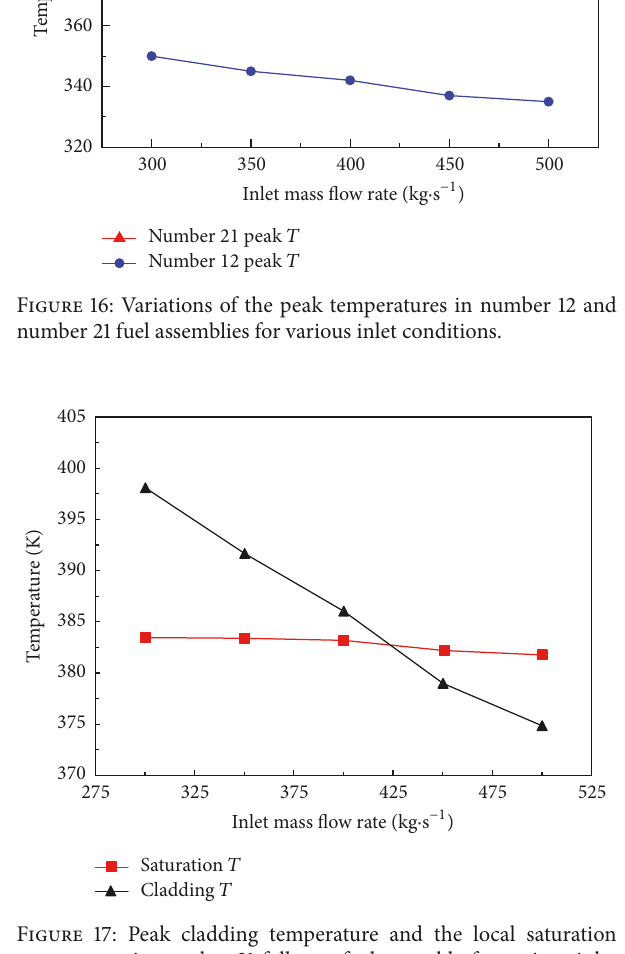
Figure 17: Peak cladding temperature and the local saturation temperature in number 21 follower fuel assembly for various inlet